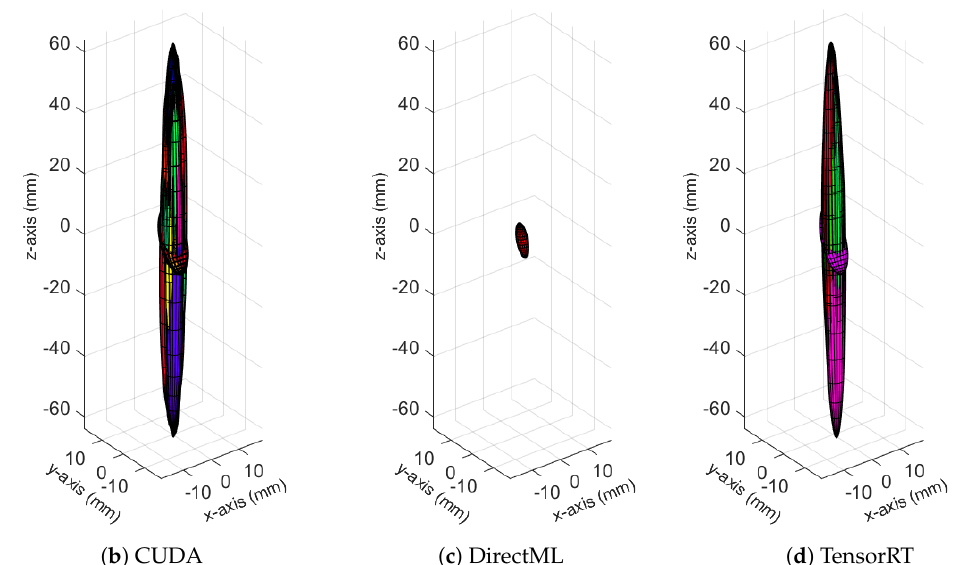
Figure A5. Ellipsoids for the joint position of FOOT_LEFT for all four processing modes. The different colors represent different body tracking